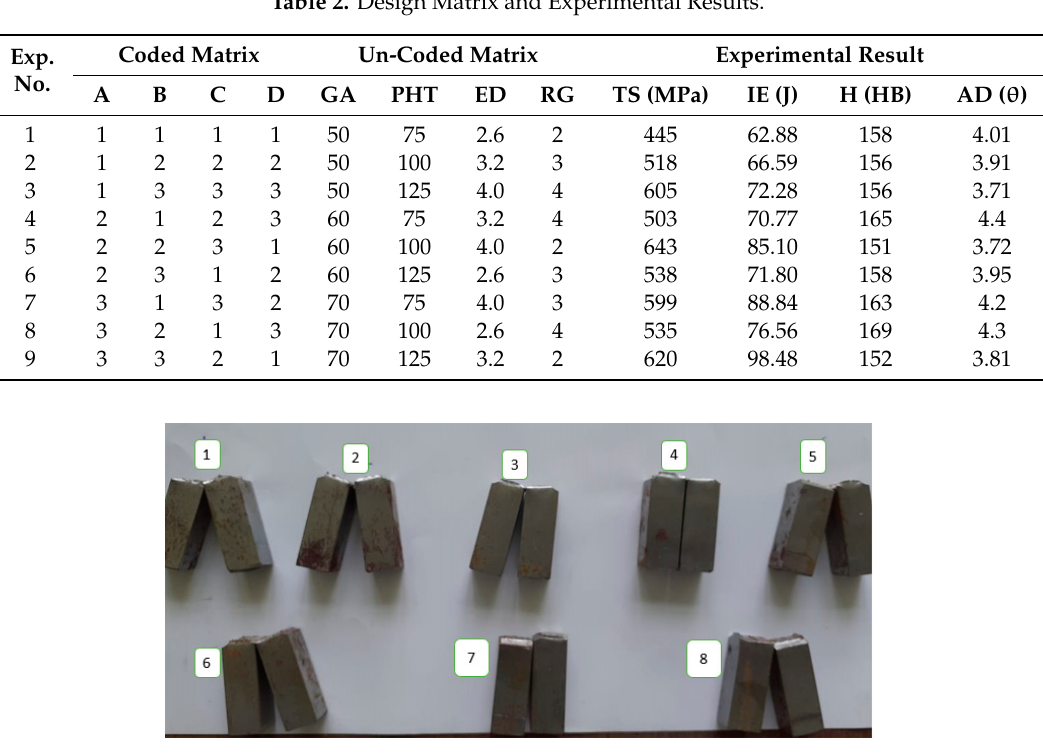
Figure 2. Charpy Impact Test Samples for: (1) Experiment 1; (2) Experiment 2; (3) Experiment 3; (4) Experiment 4; (5) Experiment 5; (6) Experiment 6; (7) Experiment 7; (8) Experiment 8.